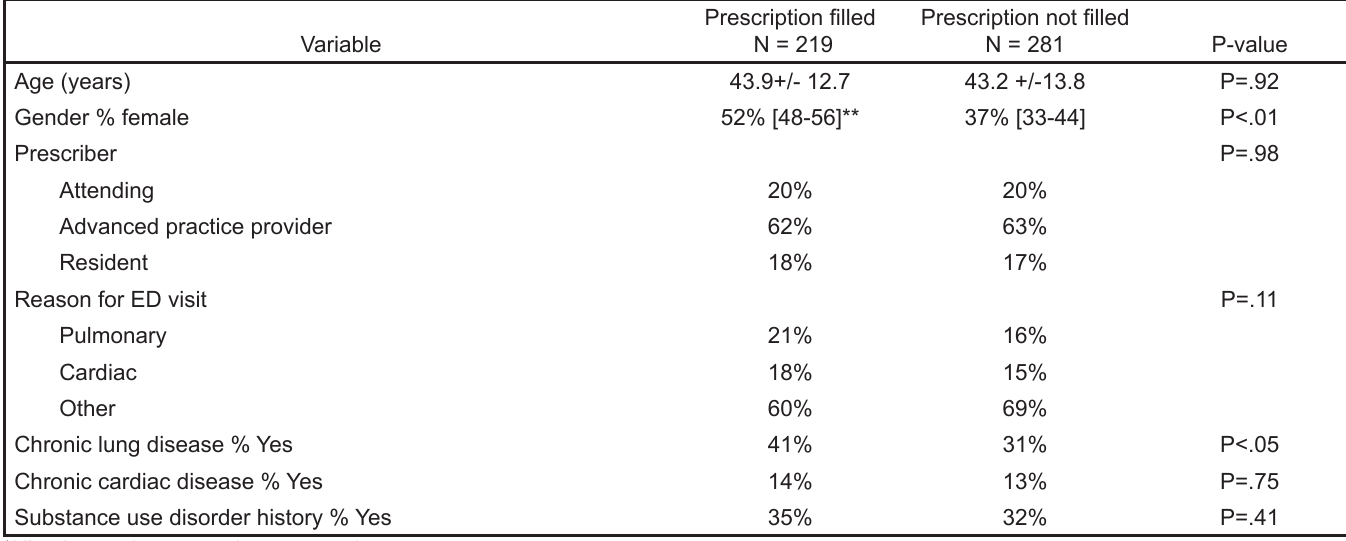
Table 1. Relationship with NRT-P*